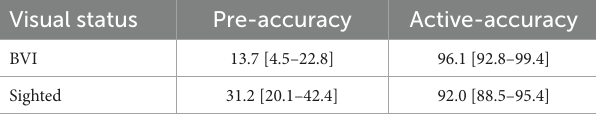
TABLE 6 Summary of pre/post accuracy collapsed across diagram and mode.